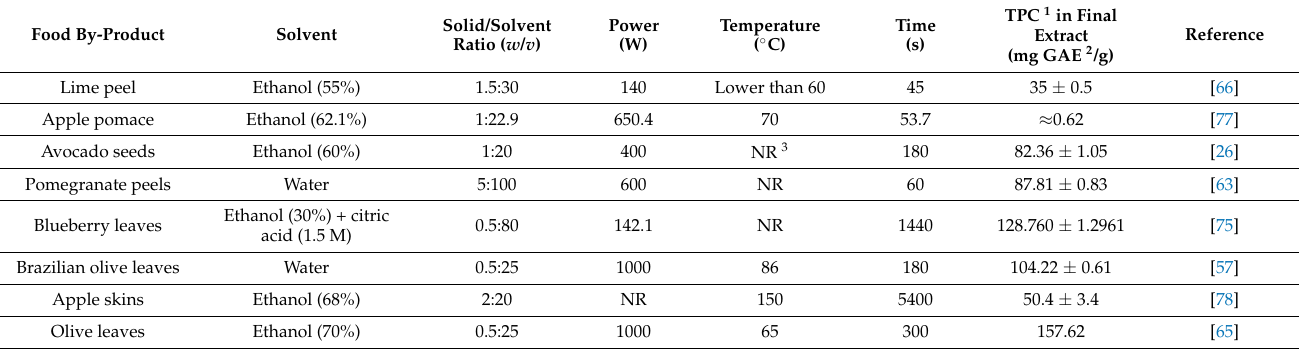
Table 2. Recovery of polyphenols from various food by-products using